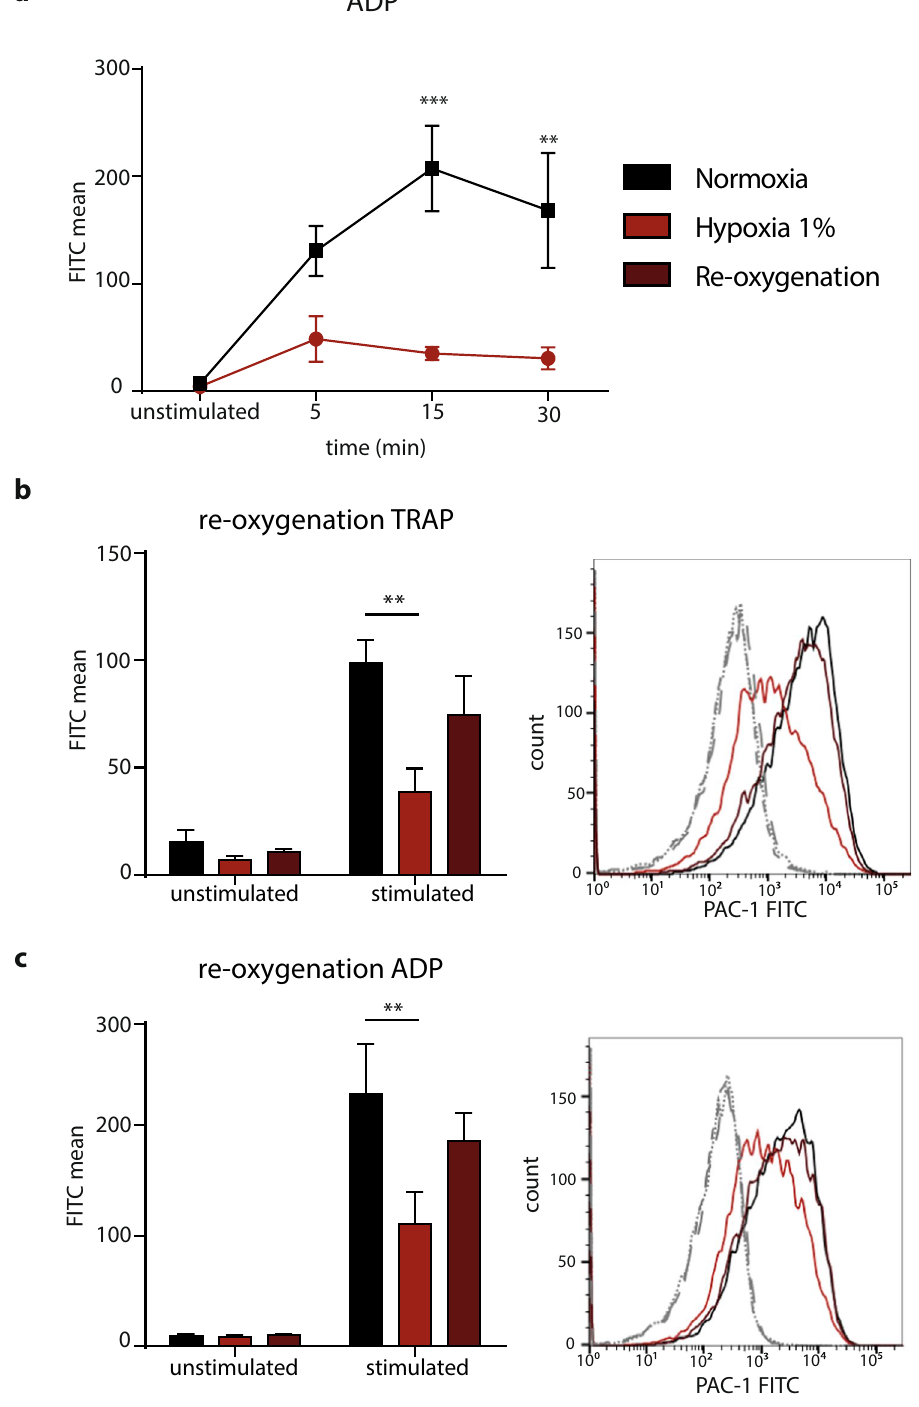
Figure 3. Impaired activation of α IIb β 3 after platelet incubation in hypoxia is fast and reversible. ( a ) Mean fluorescence intensity of PAC-1 binding to buffer- diluted PRP, unstimulated or stimulated with 5 µ M ADP (n = 3) after 5, 15, and 30 min incubation in normoxia (black) or hypoxia (red). ( b ) Mean fluorescence intensity of PAC-1 binding to buffer- diluted PRP, unstimulated or stimulated with 5 µ M TRAP-6 after 30 min incubation in normoxia (black), 30 min incubation in hypoxia (red), and 15 min incubation in hypoxia followed by 15 min incubation in normoxia (brown) (n = 4). ( c ) Mean fluorescence intensity of PAC-1 binding to buffer- diluted PRP, unstimulated or stimulated with 5 µ M ADP after 30 min incubation in normoxia (black), 30 min incubation in hypoxia (red), and 15 min incubation in hypoxia followed by 15 min incubation in normoxia (brown) (n = 4). All data were expressed as the means ± SEM. Statistical comparisons were performed using the two-way ANOVA, ** p < 0.01, *** p ≤